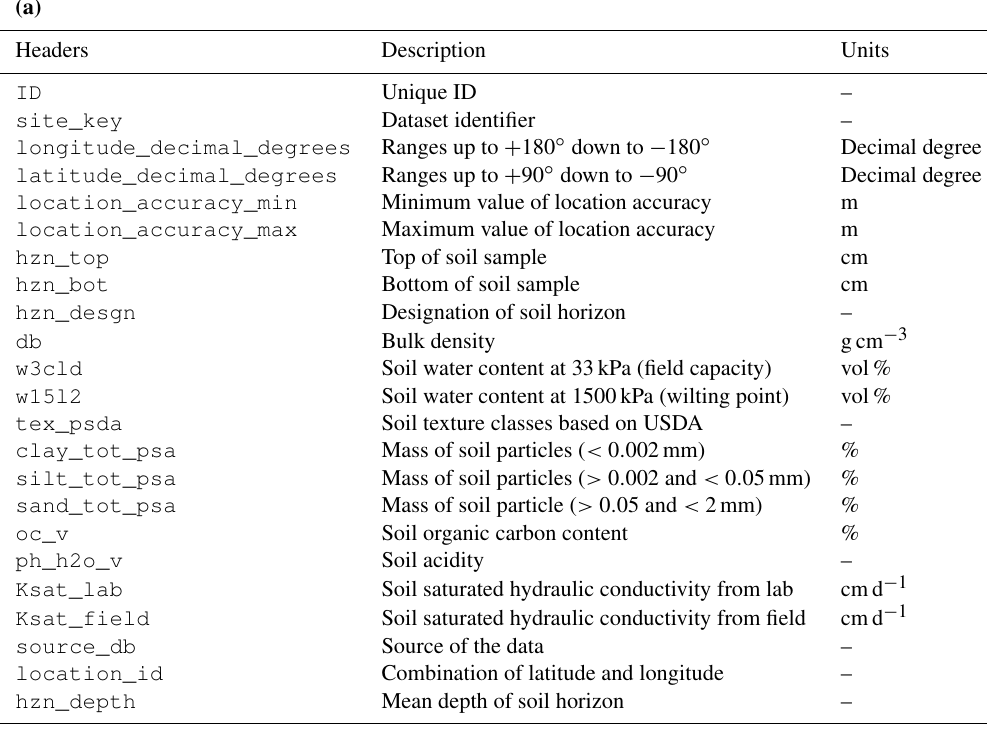
Table 2. (a) Description and units of some key variables listed in the database. The list can be found in the readme file (Table 1) and dataset “sol_ksat.pnts_horizons” on Zenodo (https://doi.org.10.5281/zenodo.3752721). We used the same codes as in the National Cooperative Soil Survey (NCSS) Soil Characterization Database (National Cooperative Soil Survey, 2016). (b) Example of K sat database structure with key variables (from left to right: unique ID, reference, longitude and latitude (decimal degree), minimum and maximum accuracy (m), top and bottom of soil sample (cm), horizon designation, bulk density (gcm − 3 ), moisture content at field capacity and wilting point (%), soil textural class, clay, silt and sand content (%), soil organic carbon content (%), soil acidity, saturated hydraulic conductivity measured in lab or field (cmd − 1 ), source of the data, location id, and mean soil depth). NA is “no value”. Column names are explained in (a) . The dataset file “ sol_ksat.pnts_horizons ” can be found on Zenodo